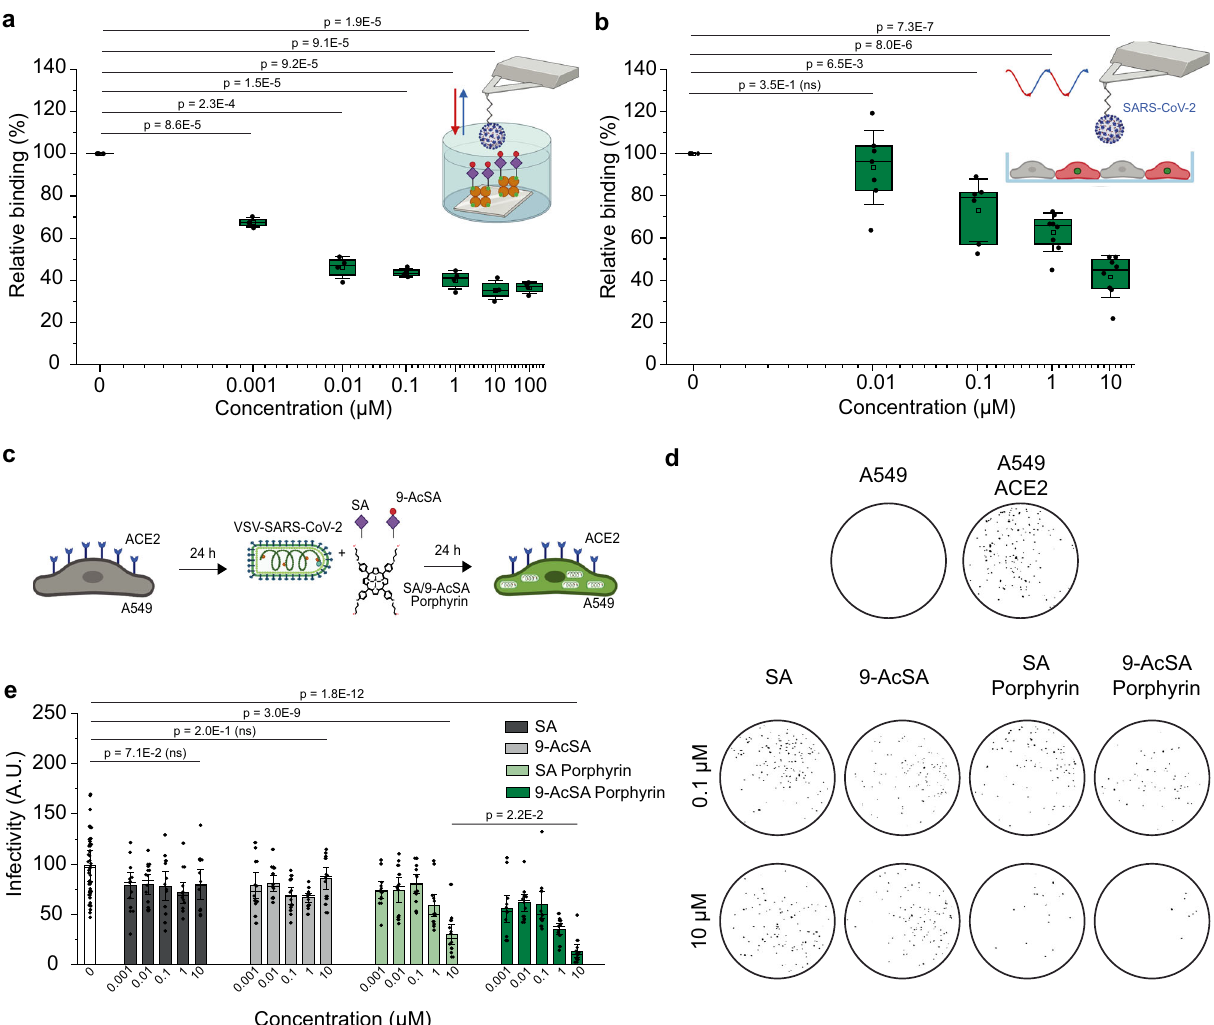
Fig. 6 Characterization of AcSA-derived porphyrin 11 as a binding and infectivity inhibitor. a , b Probing 9-AcSA-porphyrin ef fi ciency to inhibit SARS- CoV-2 binding to acetylated SA on model surfaces and living cells at low concentrations. Box plot showing the relative binding values of the interaction between SARS-CoV-2 and a 9-AcSA model surfaces or b CHO cells before and after incubation with 9-AcSA-derived porphyrin 11 at increasing µ M concentrations. The square in the box indicates the mean, the colored box the 25th and 75th percentiles, and the whiskers the s.d. of the mean value. The line in the box indicates the median. P -values were determined by two-sample t test in Origin. Data are representative of at least N = 3 independent experiments (tips and sample) per SA dendrimer concentration. c – e Infectivity assay. c Schematics: A549 and A549-ACE2 cells were seeded in 96-well plates for 24h. SARS-CoV-2 spike pseudotyped virus and either SA, 9-AcSA, SA/9-AcSA porphyrin were incubated for 15 min at room temperature and added to the 96-well plate. The infectivity was measured 24 h later. d The images of infected cells in a well in the presence of either 0.1 µ M or 10 µ M of SA, 9-AcSA, SA/9-AcSA Porphyrins 10 and 11 . e The infectivity measured in the presence of SA, 9-AcSA, SA/9-AcSA porphyrin. Each dot shows the infectivity from a well. The colored box indicates the mean and the whiskers the s.d. of the mean value. The line in the box indicates the median. P -values were determined by two-sample t test in Origin. Cartoons in panels a – c were created with BioRender.com. Source data are provided as a Source Data fi